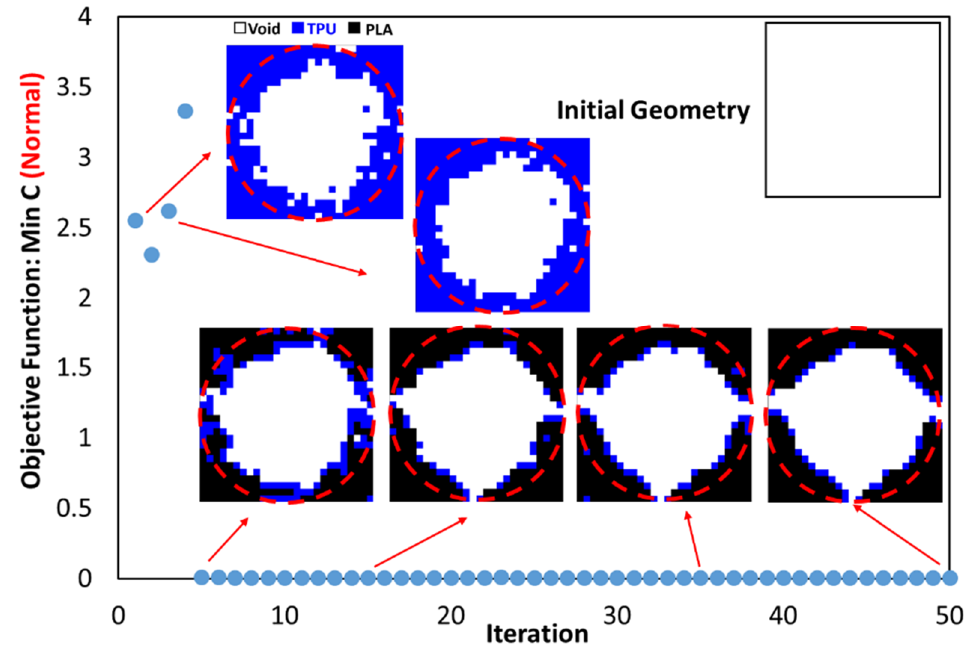
Figure 16. The convergence diagram of the objective function in tire optimization.